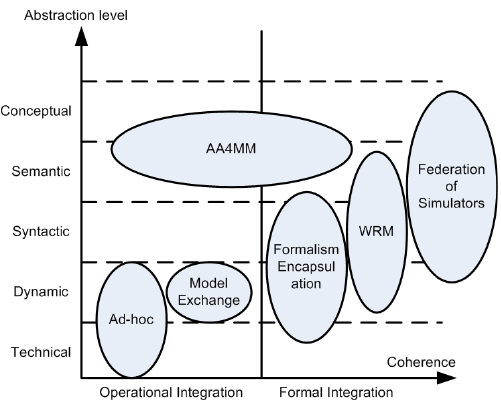
Figure 11. Reviewed coupling methods and their associated abstraction